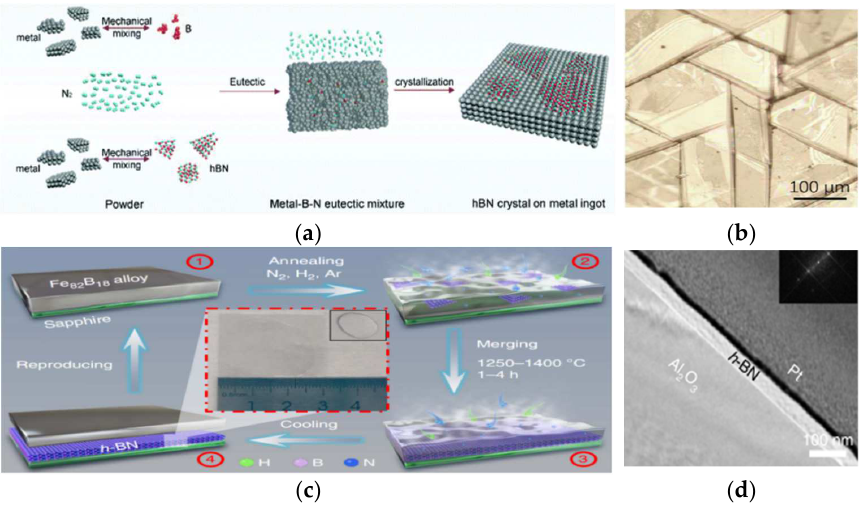
Figure 22. ( a ) Schematic of the procedure of h-BN growth. ( b ) Zoom-in optical image of h-BN films showing grain boundaries that roughly follow three directions. ( c ) Schematics of multilayer h-BN grown on sapphire with Fe 82 B 18 alloy and nitrogen as reactants. ( d ) Corresponding TEM images of multilayer h-BN with different thicknesses [105,106] .